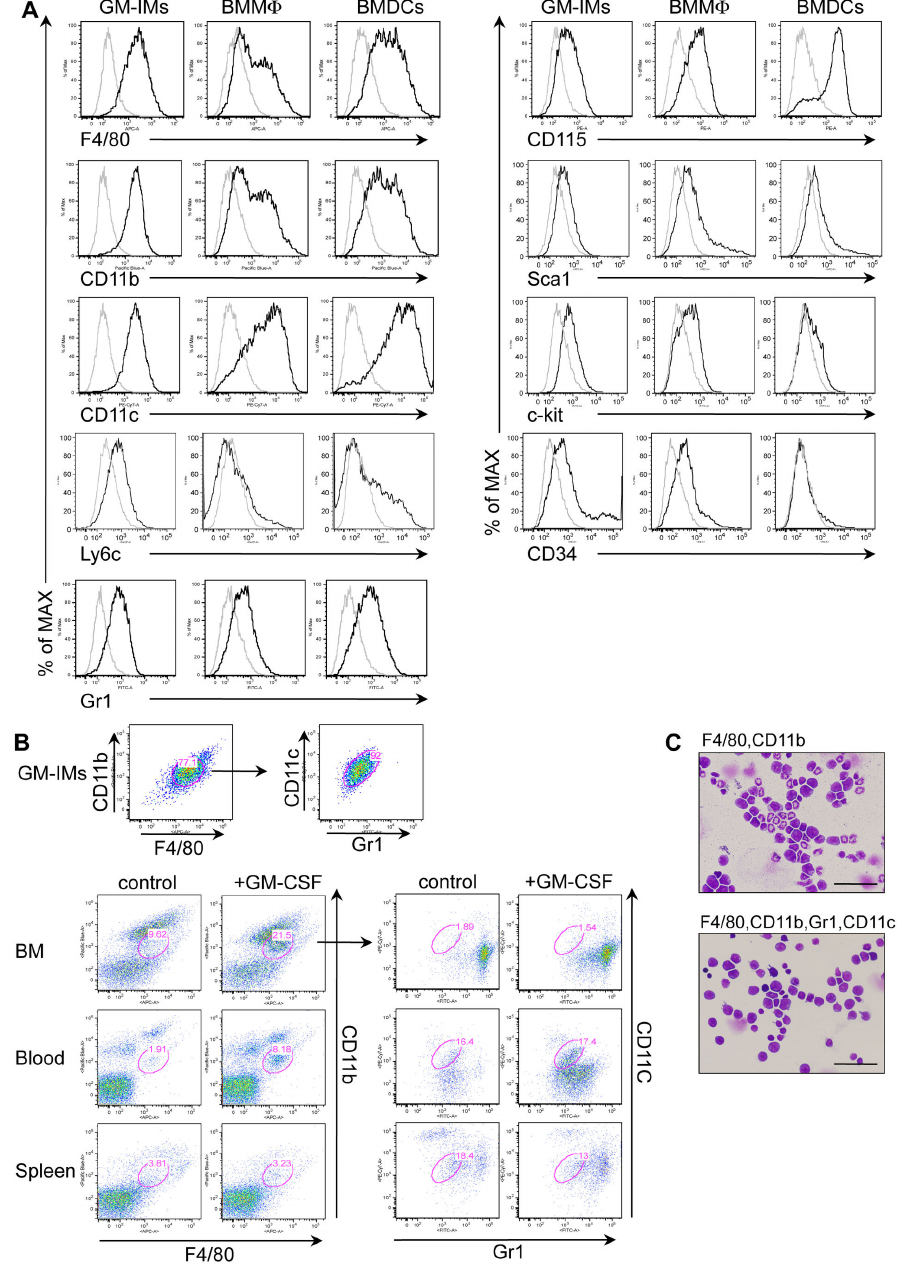
Figure 4. Expression of macrophage lineage makers on GM-IMs. (A) GM-IMs cultured for more than nine months in 10% GM- CSF-CM were compared with BMMφ or BMDCs cultured for ten days in 10% GM-CSF-CM. They were collected and stained with indicated antibodies and analyzed by flow cytometry using a FACSCanto. (B) BM cells, blood nucleated cells and splenocytes were collected from control mice and mice that had been injected intraperitoneally twice (once per week) with three mL of 10% GM-CSF-CM and were analyzed after two weeks. These cells and GM-IMs were detected by F4/80 and CD11b expression and were gated to assess CD11c and Gr-1. (C) C57BL/6 mice were injected once with three mL of 10% GM-CSF-CM. After seven days, BM cells were prepared and stained with FITC-anti-Gr1, APC-anti-F4/80, eFluor450-anti-CD11b and PE-Cy7-anti-CD11c. Stained cells were sorted with a wide gate (CD11b and F4/80) or a narrow gate (F4/80, CD11b, CD11c, Gr-1). Cells underwent Cytospin preparation and were stained with May-Grunwald-Giemsa. Scale bars: 50 µm. Data are representative of three (A, B) or two (C) independent experiments with similar results. doi: 10.1371/journal.pone.0076943.g004 PLOS ONE |